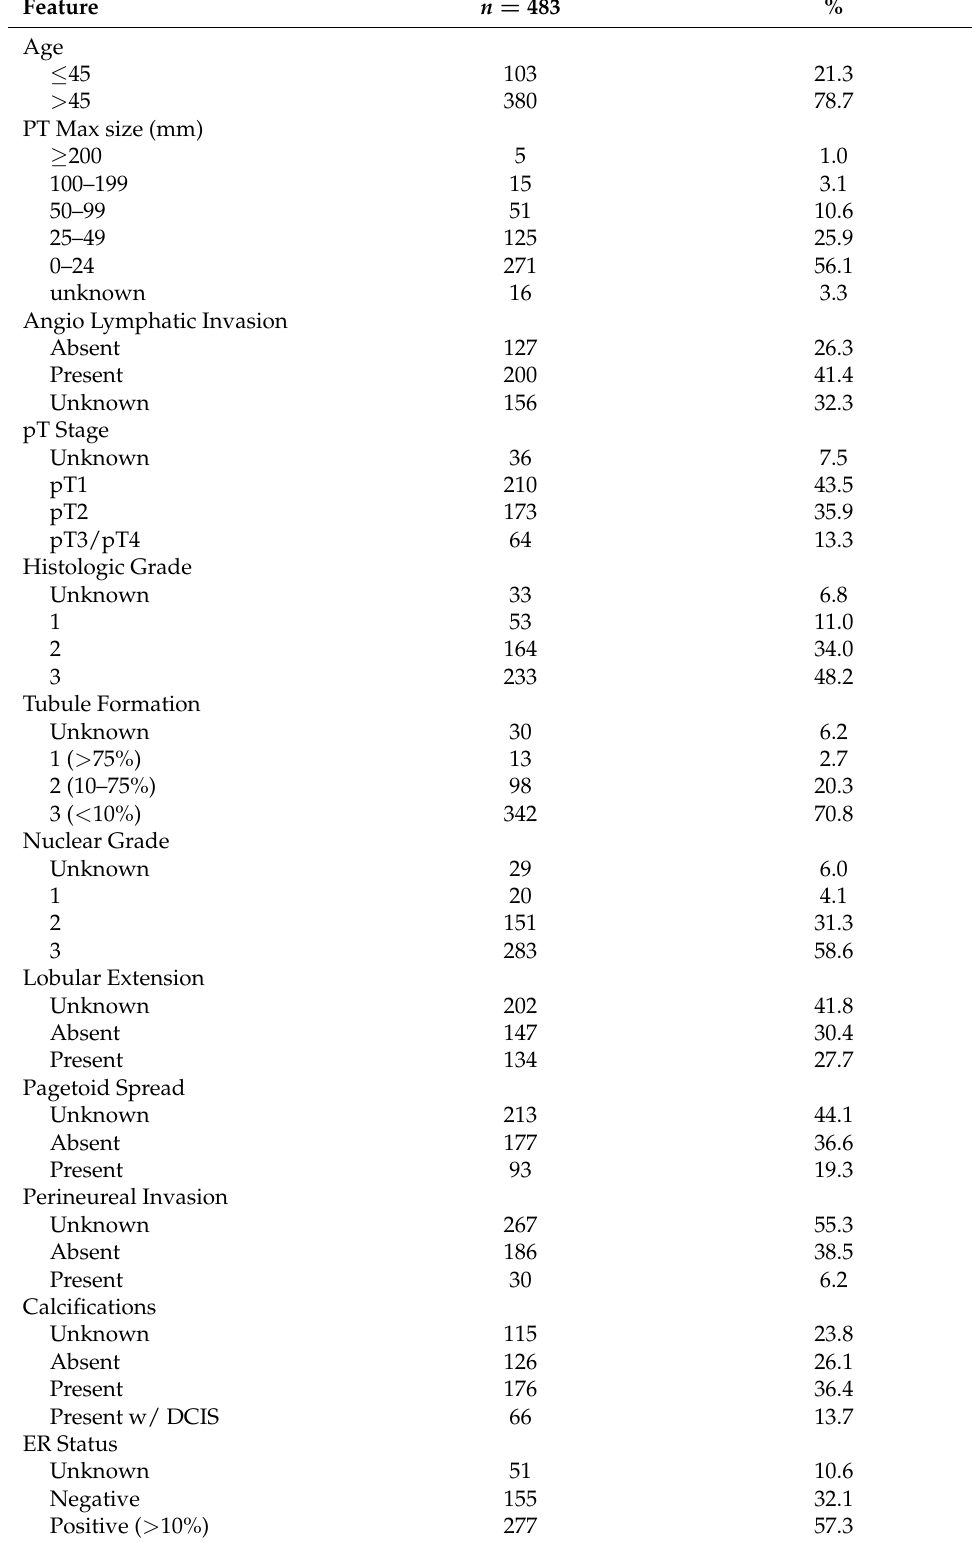
Table 2. Characteristics of patient